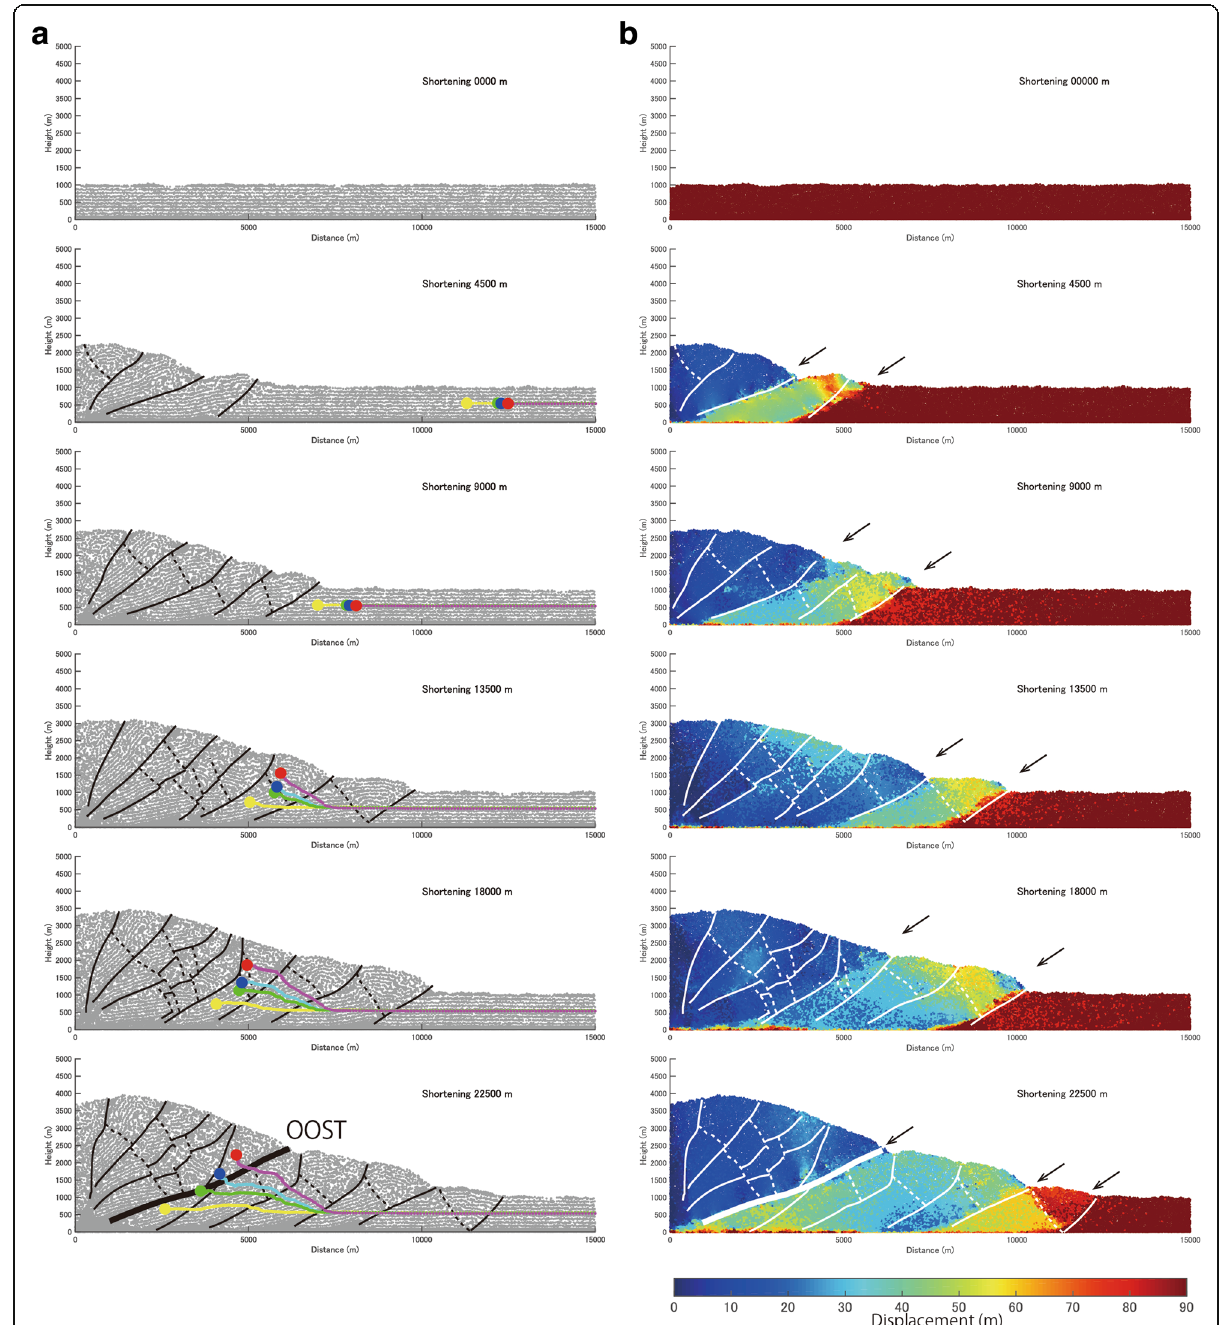
Fig. 3 The sequential simulation results and the relative displacement of particles toward the moving wall while performing 90 m of shortening (0 – 22,500 m of shortening). The colored particles on the simulation results are the target particles that can be used for monitoring their depth, temperature, and vitrinite reflectance (Fig. 4). The trajectories of the particles are also depicted in the figure. The solid black lines in a and white lines in b are fore thrust, and the dashed black lines in a and white lines in b are back thrust. The thick solid black line in a and white line in b depict the OOST. The black arrows represent the displacement boundaries that are associated with active